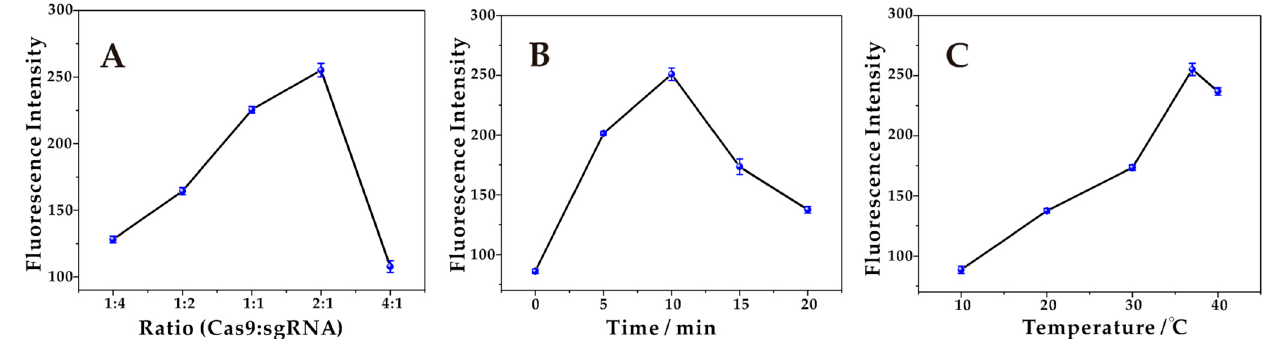
Figure 2. ( A ) Optimization of the concentration ratio of Cas9:sgRNA. The fluorescence intensity reaches a maximum at a ratio of 2:1. ( B ) Optimization of the incubation time for the formation of Cas9-sgRNA. The fluorescence intensity reaches a maximum at 10 min. ( C ) Optimization of the incubation temperature for the formation of Cas9-sgRNA. The fluorescence intensity reaches a maximum at 37 °C.